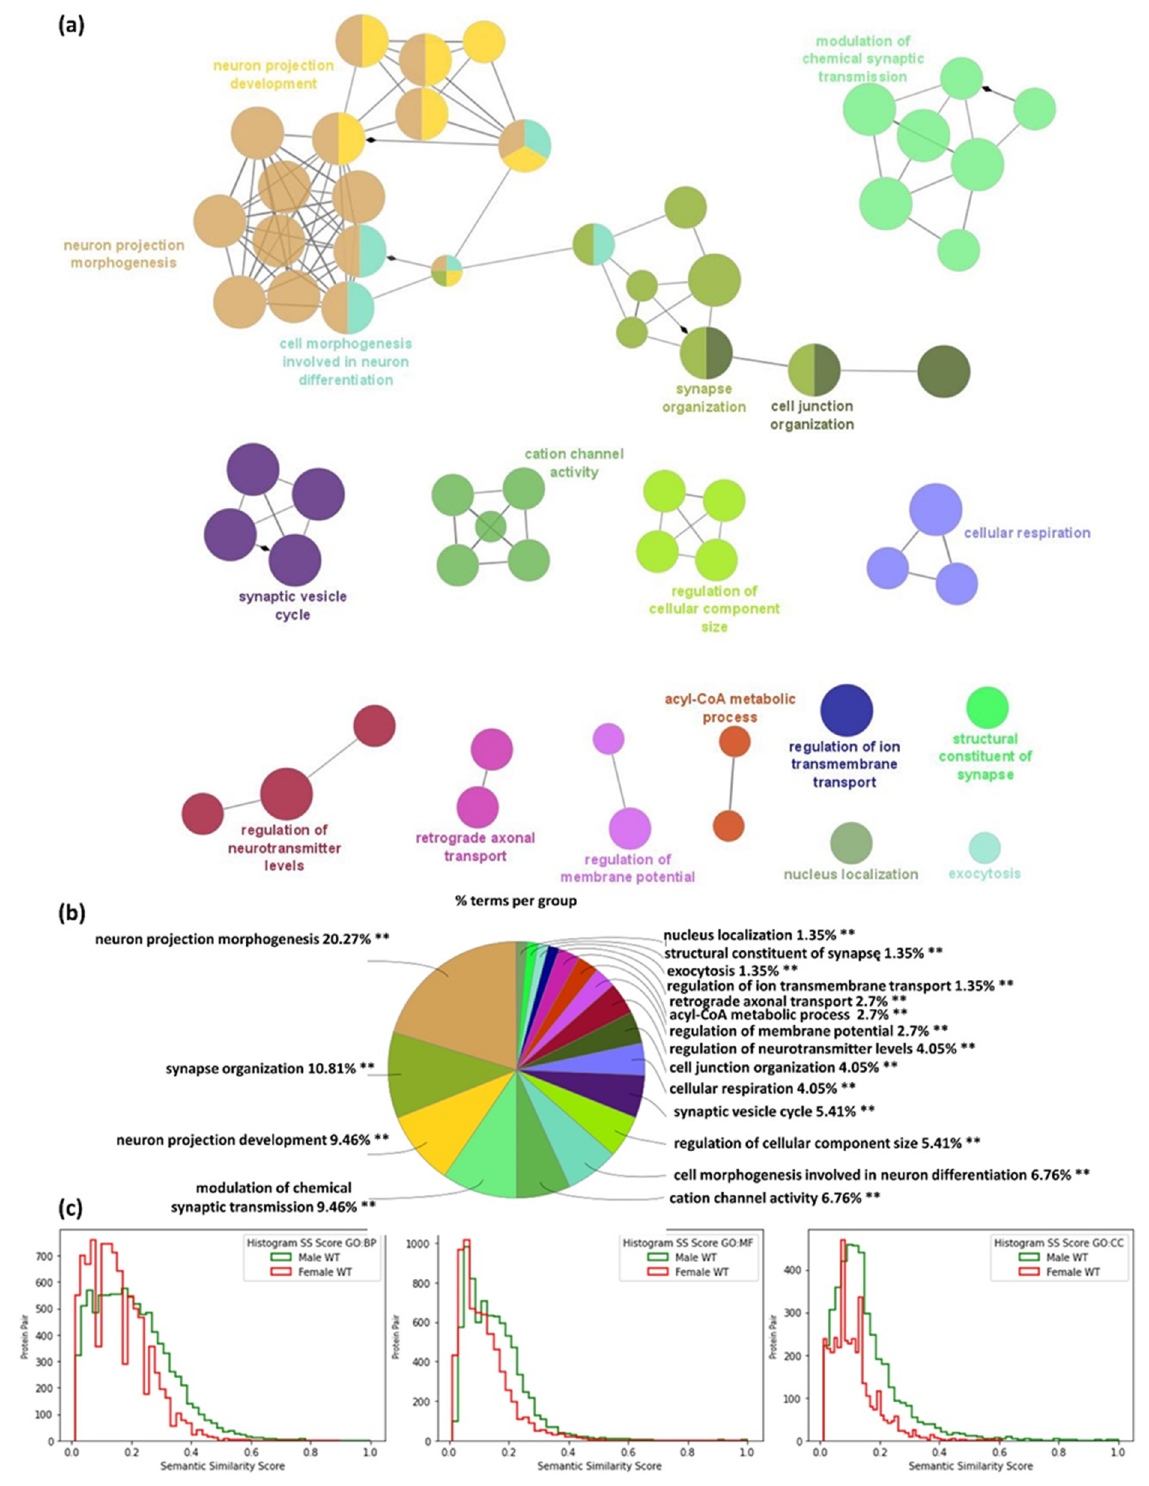
Figure 4. Functional enrichment analysis of proteins specific for male WT mice using the Gene Ontology biological processes database and the Clue Go algorithm. ( a ) Network depicting interactions between enriched functional classes. ( b ) A diagram showing the percentage of terms per group analysis of enriched protein classes. ( c ) Comparison of semantic similarity (SS) of protein pairs from male and female WT mice for each type of Gene Ontology term: cellular components (CC), molecular functions (MF) and biological processes (BP), respectively. The X -axis represents the SS score (ranges—0, 1) and the Y- axis represents the frequency of protein pairs.